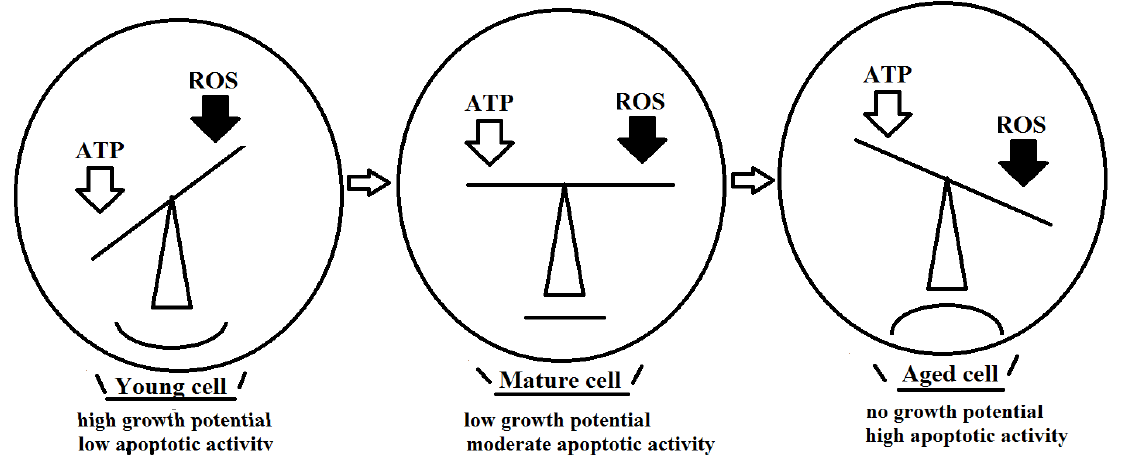
Figure 1. Relative interrelationships between ATP and ROS production in the course of cellular senescence. See description in the text.